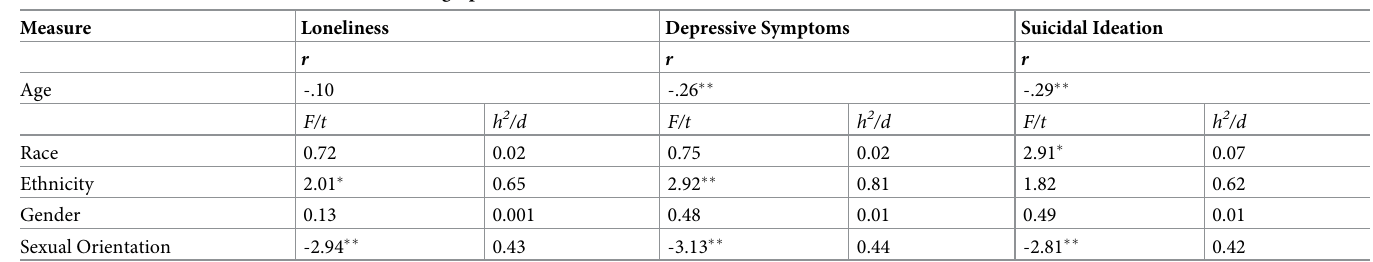
Table 3. Associations between outcomes and demographic covariates.